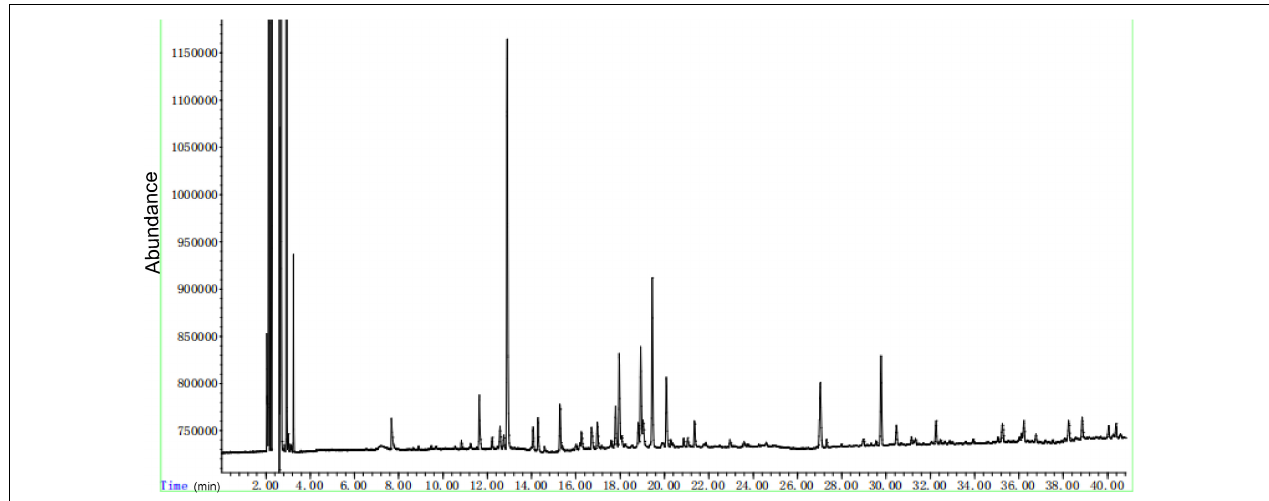
FIGURE 1 | The fingerprint of AAEO performed by gas chromatography.